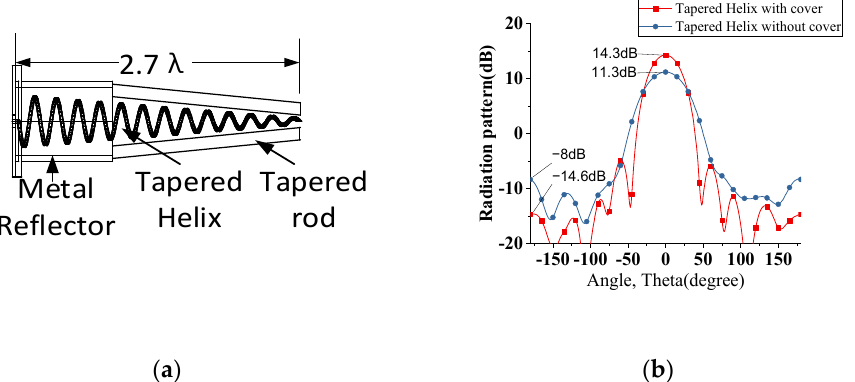
Figure 4. ( a ) Gives the schematic of tapered helix with tapered dielectric cover ( b ) The gain and side lobe level comparison of tapered helix with and without tapered dielectric